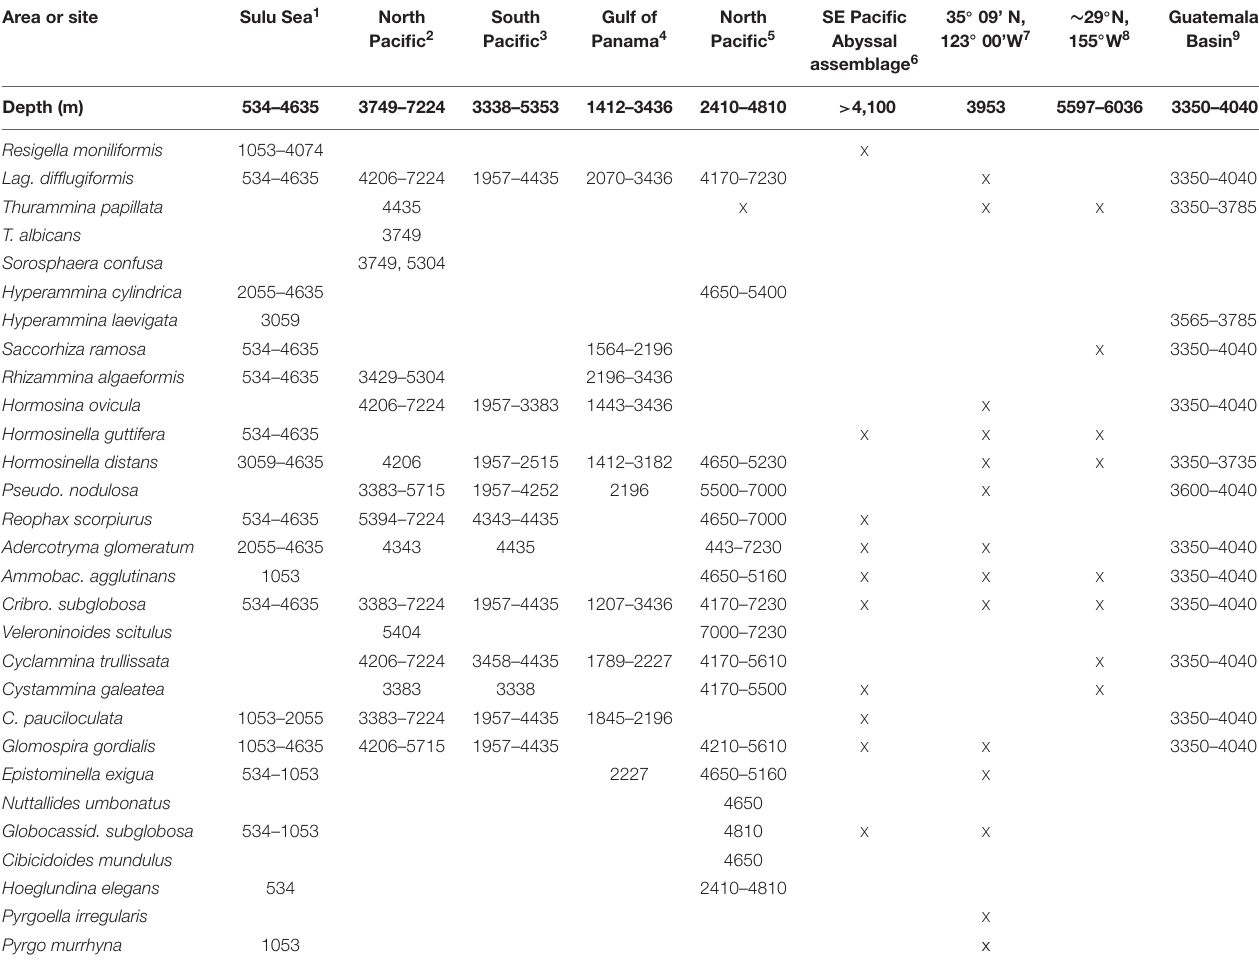
TABLE 7 | Literature records from the Pacific Ocean of selected foraminiferal species that occur in the UK-1 and OMS contract areas. Area or